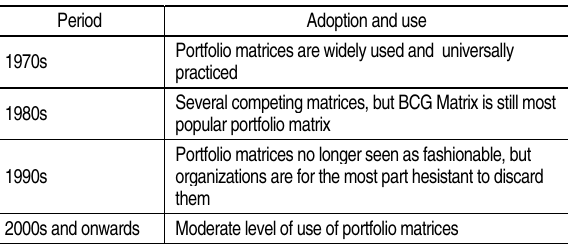
Table 6. Trends in the adoption and use of the BCG Matrix over